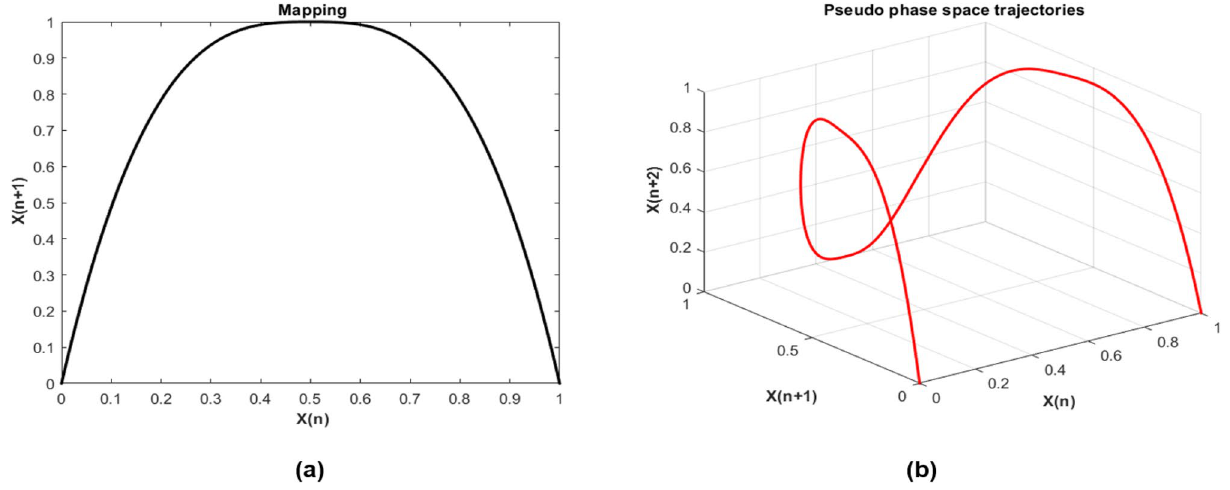
Fig. 3 Shows the a mapping and b pseudo phase space trajectory for third order symmetric chaotic